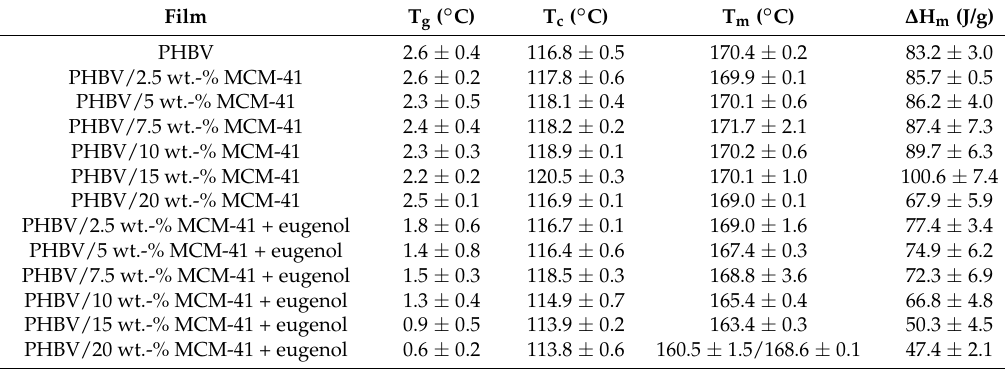
Table 2. Thermal properties in terms of glass transition temperature (T g ), crystallization temperature (T c ), melting temperature (T m ), and normalized enthalpy of melting ( ∆ H m ) for the electrospun films of poly(3-hydroxybutyrate- co -3-hydroxyvalerate) (PHBV) and PHBV/Mobil Composition of Matter (MCM)-41 without and with